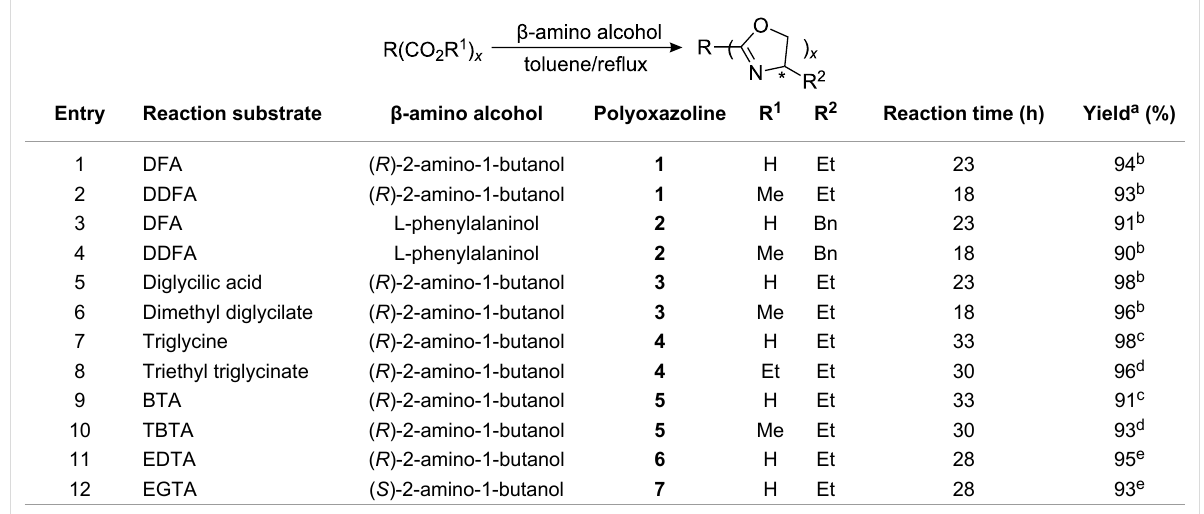
Table 1: The conditions and results of the reaction of polycarboxylic acids or their esters with chiral β -amino alcohols.